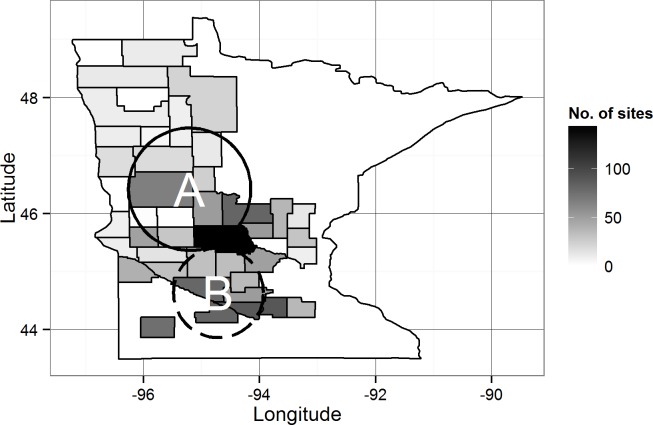
Time-space clusters of high (A, continuous line) and low (B, dashed line) predicted probability of sharing PRRS status from July 2012 to June 2014 in the RCP-N212.Counties delineated at the edges have premises enrolled in the RCP-N212 and shade scale depicts the total number of premises per county (Census 2102. USDA, 2014).